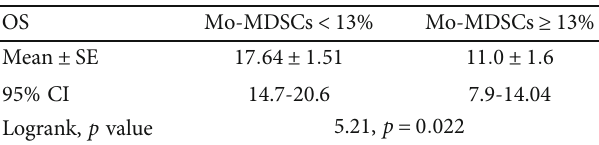
Figure 3: Di ff erences in the mean myeloid-derived suppressor cells (Mo-MDSCs) according to 1-year survival in each stage, p < 0 : 0001 . Table 5: Di ff erence of OS according to Mo-MDSC levels among NSCLC